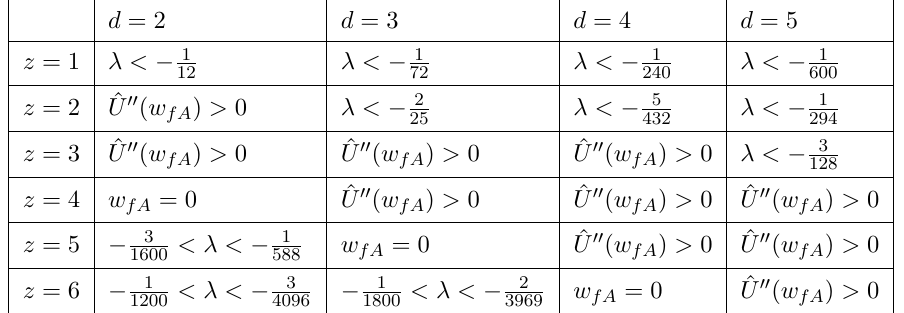
Table 1 . The appropriate ranges of the coupling constant λ for which w fA 1 is a maximum outside the horizon. For some values of d and z , one has ˆ U 00 ( w